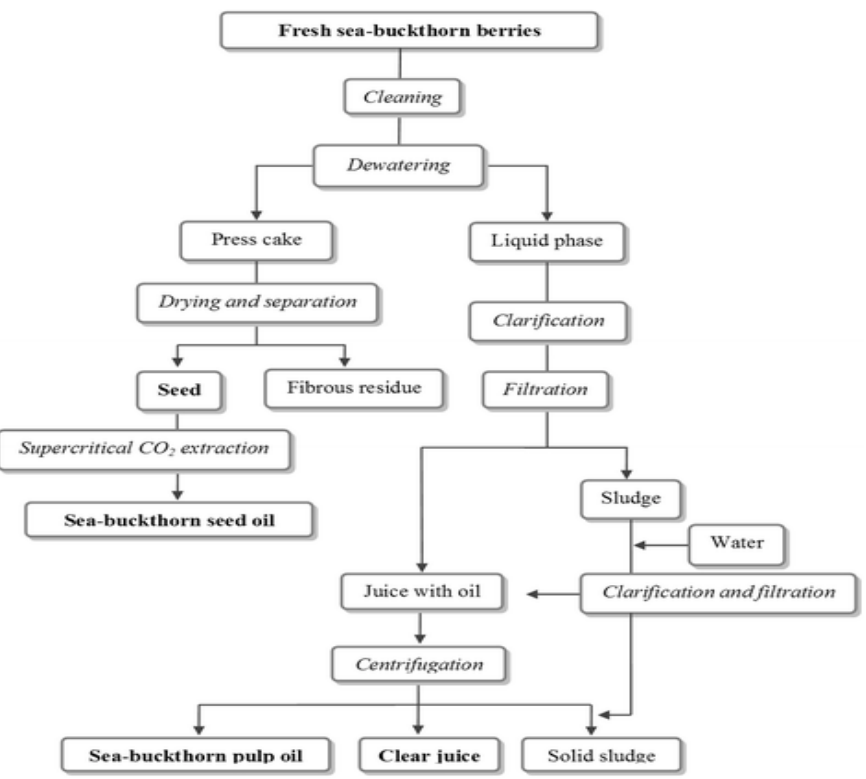
Figure 1. Method for processing SB berries.